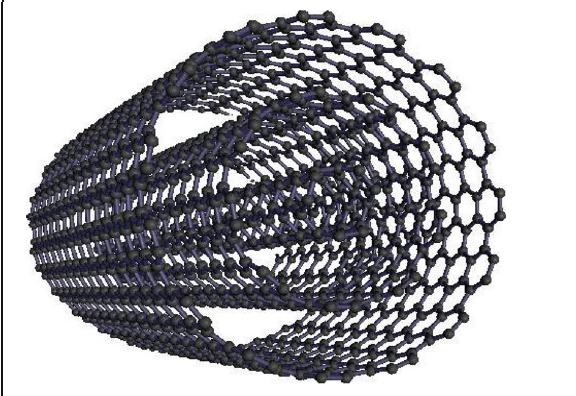
Fig. 4 Multiwall carbon nanotube (MWCNT)